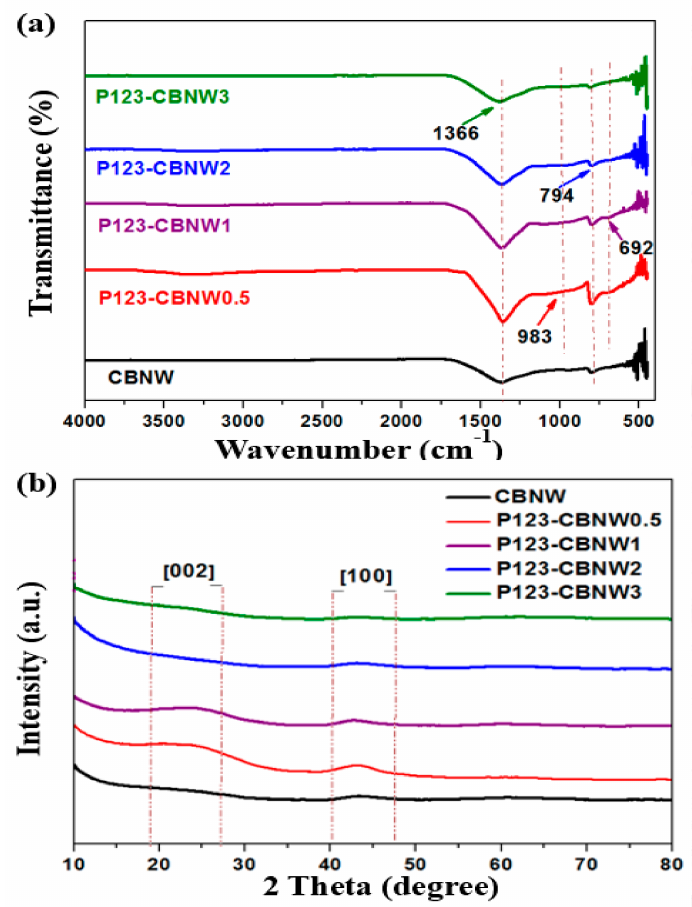
Figure 4. ( a ) FTIR spectra and ( b ) XRD patterns of CBNW, P123-CBNW0.5, P123-CBNW1, P123-CBNW2 and P123-CBNW3